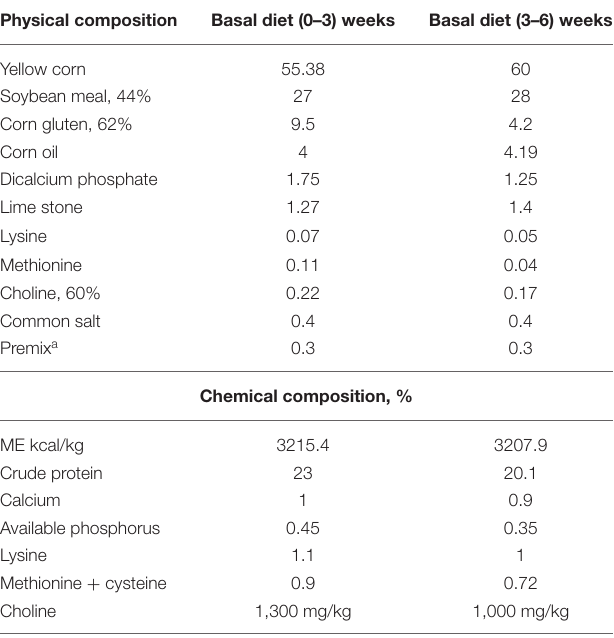
TABLE 1 | Ingredients and calculated chemical composition of basal